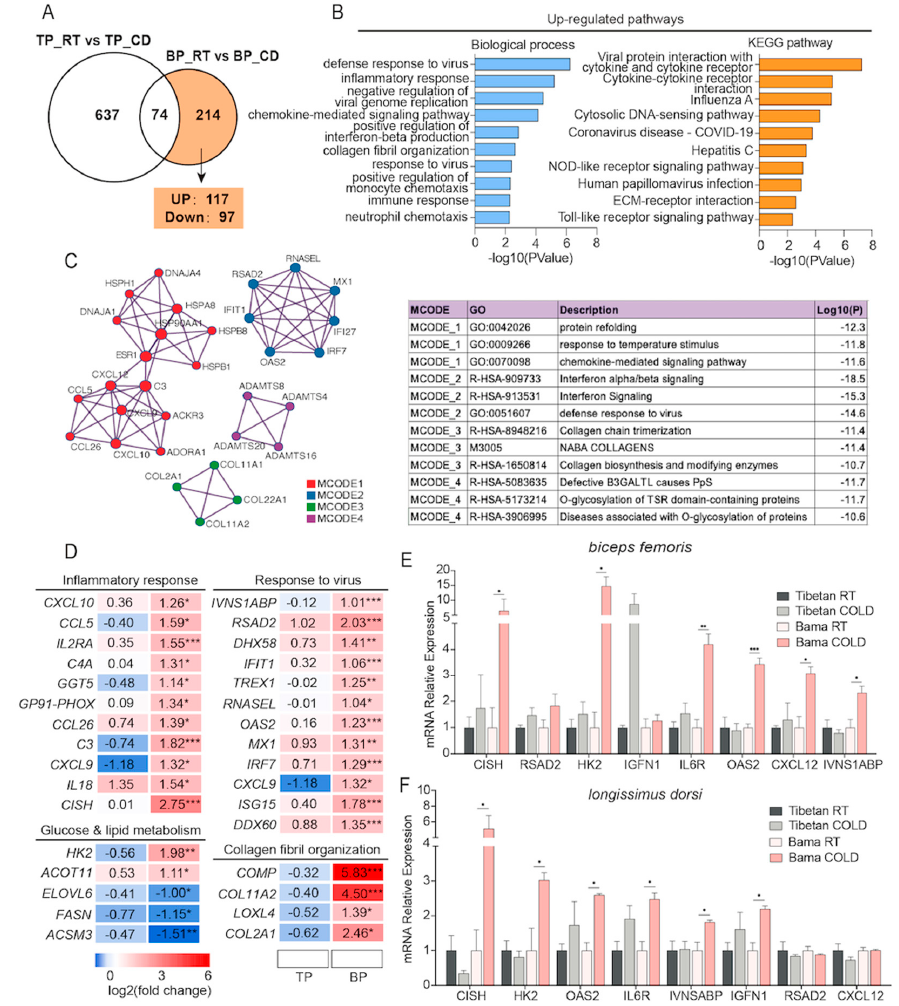
Figure 4. Short-term cold exposure uniquely regulates inflammatory response-related genes in BP. ( A ) Venn diagram showing the number of uniquely regulated DEGs in BP. ( B ) GO terms and KEGG pathway analyses of upregulated DEGs. ( C ) A PPI network of uniquely regulated genes in BP. The molecular complex detection (MCODE) algorithm was applied to identify densely connected network components. Each MCODE network was assigned a unique color. The three highest scoring terms with the highest by p -value were retained as the functional descriptions of the corresponding components, as shown in the table under the network diagram. ( D ) Heatmaps showing the relative changes in the expression of genes involved in the inflammatory response, the formation of collagen fibril organization, and glucose and lipid metabolism (n = 3). ( E , F ) qPCR validation of genes involved in the inflammatory response in the BF ( E ) and LDM ( F ). All values are presented as the mean ± SEM. * p < 0.05; ** p < 0.01; *** p <